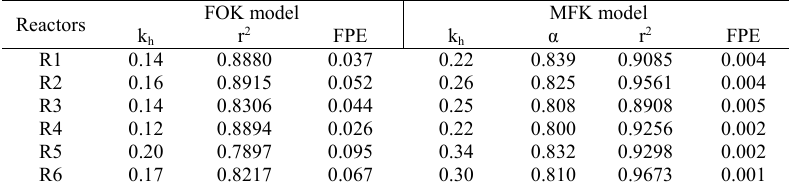
Table 3: The hydrolysis rate constant from first-order and modified first-order kinetic models Reactors